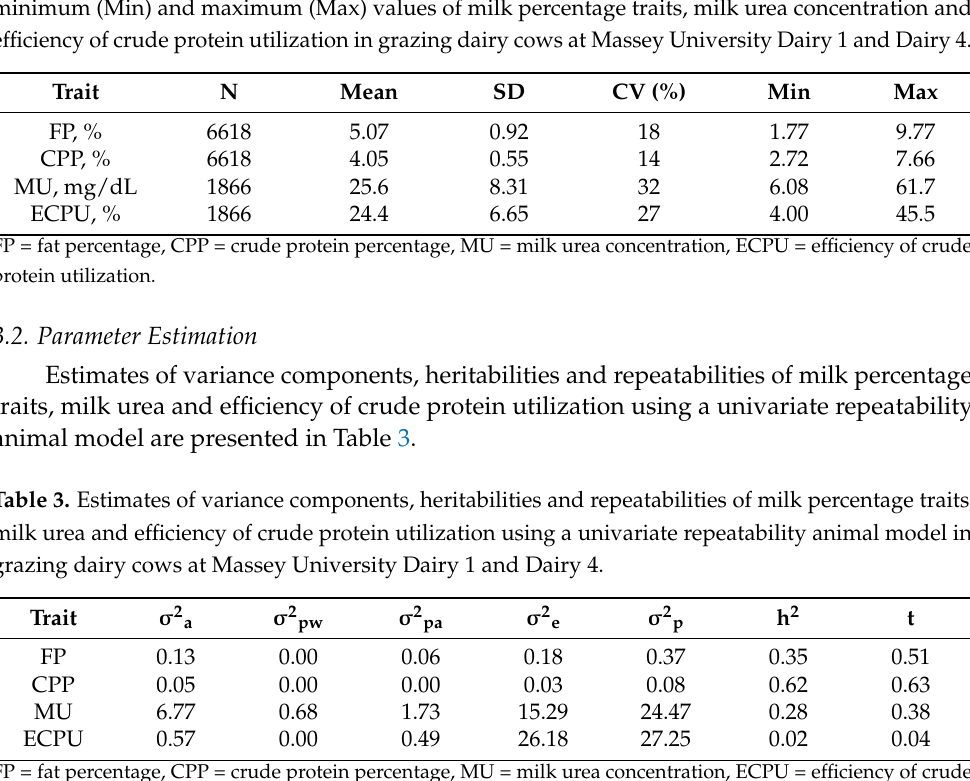
Table 2. Number of observations (N), mean, standard deviation (SD), coefficient of variation (CV), minimum (Min) and maximum (Max) values of milk percentage traits, milk urea concentration and efficiency of crude protein utilization in grazing dairy cows at Massey University Dairy 1 and Dairy 4. Trait N Mean SD CV (%) Min Max FP, % 6618